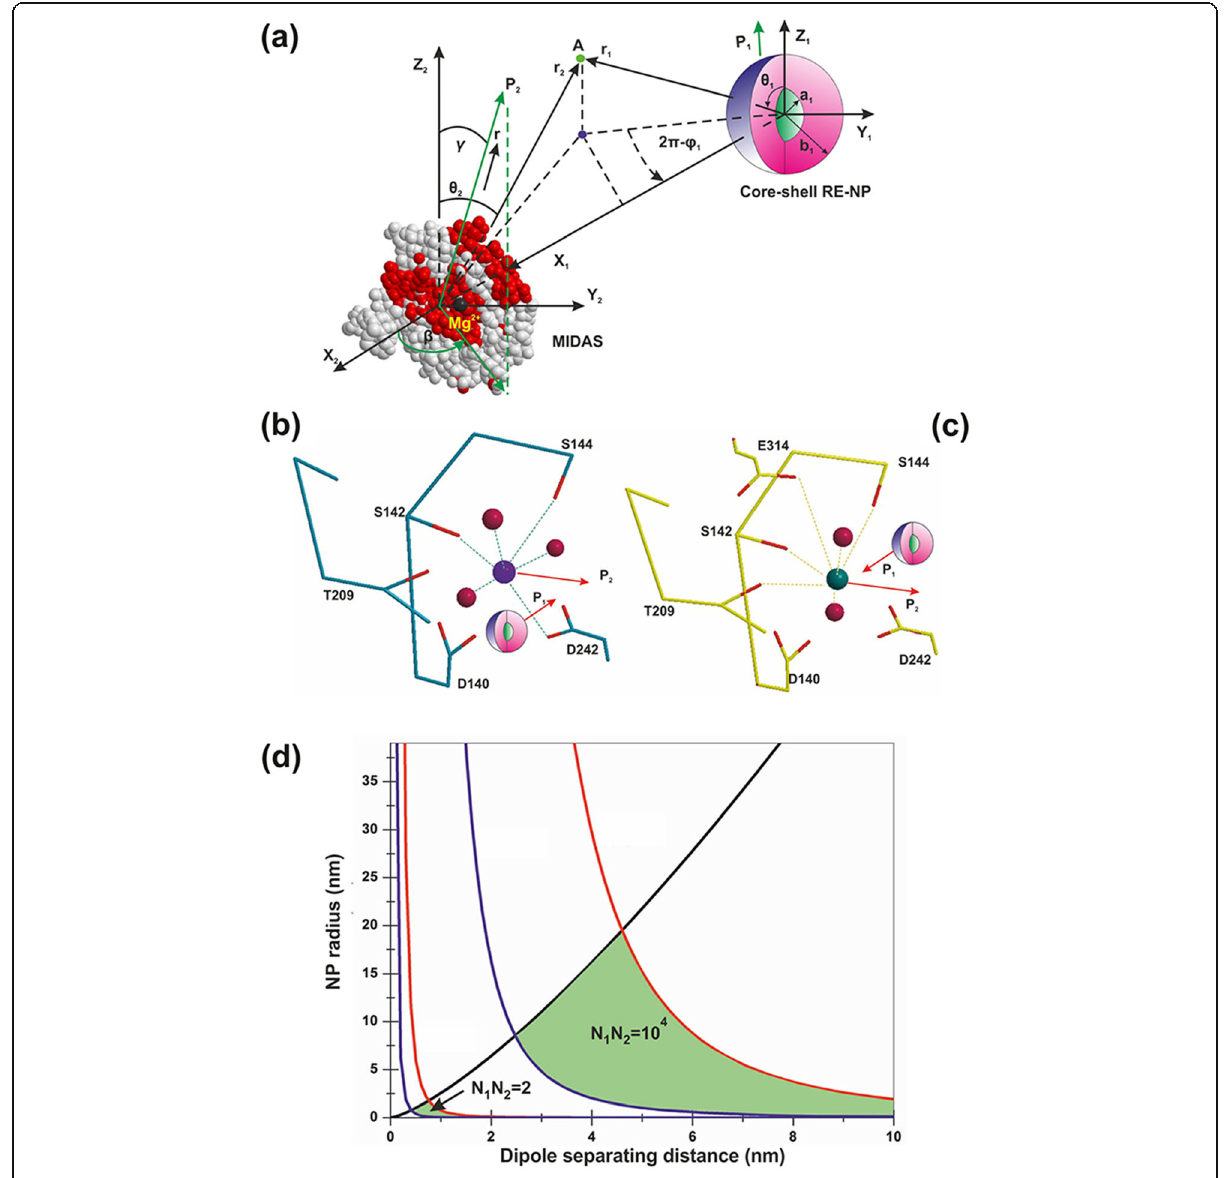
Fig. 13 a Electrical dipole interaction between one core-shell RE-NP and one LABS. b , c RE core-shell NP near a MIDAS ( b ) and ADMIDAS ( c ) adhesion sites. d Locus area (green) of the size of RE-NPs and separating distance between a LABS and a core-shell RE-NP for two electrical charging